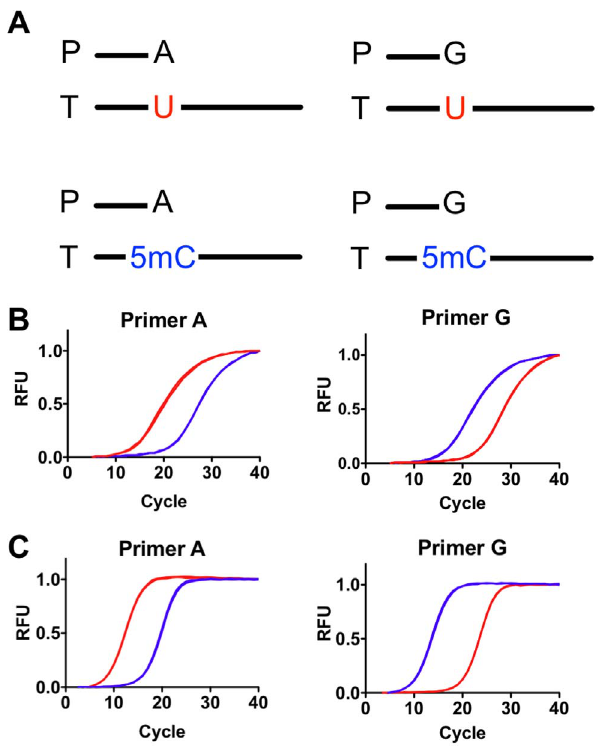
Figure 7. Real-time PCR spectra of MSP with mutant R660V. As template either a template with 5 mC (blue) or with U (red) was used. Primers A and G result in a 3’-end match or mismatch depending on the chosen template. RFU = relative fluorescence units. A) Graphic depiction of used primer (P) and template (T) setup, B) Real-time PCR curves using a commercially available kit. Template with 5 mC (blue) or with U (red) and indicated primers were used. C) Real-time PCR curves for KlenTaq R660V. Template with 5 mC (blue) or with U (red) and indicated primers were used.